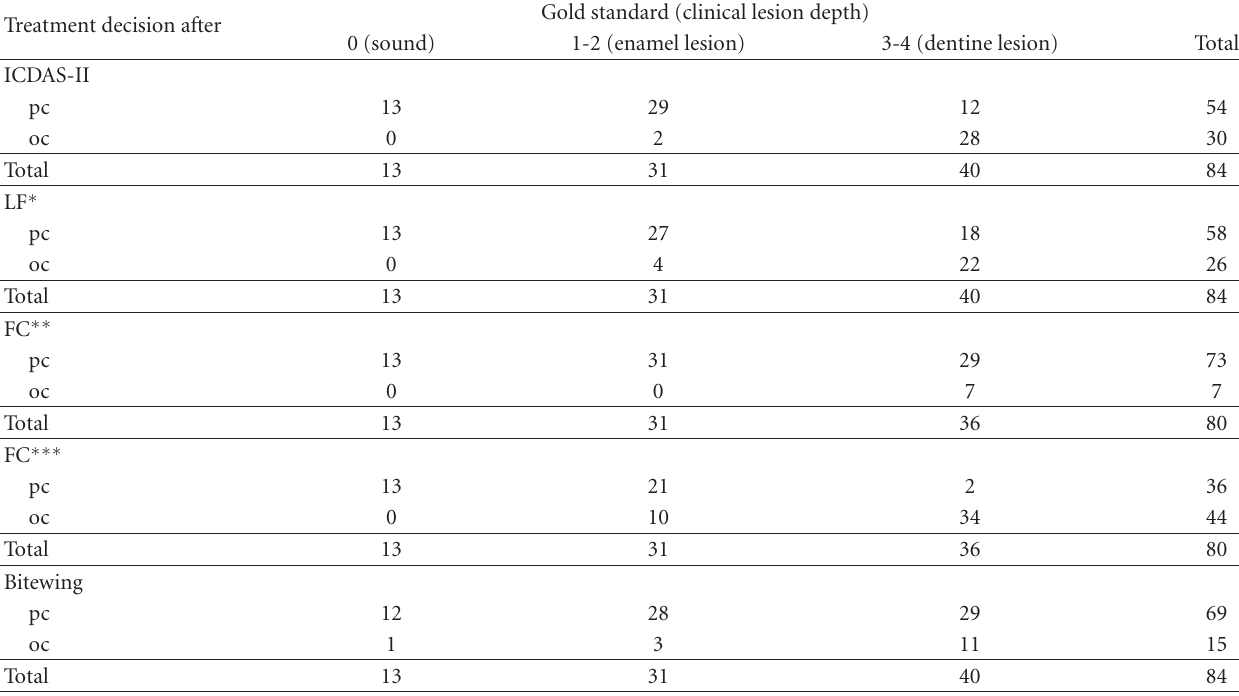
Table 7: Cross tables showing the relationship between the treatment decision according to di ff erent methods and the gold standard. Treatment decision